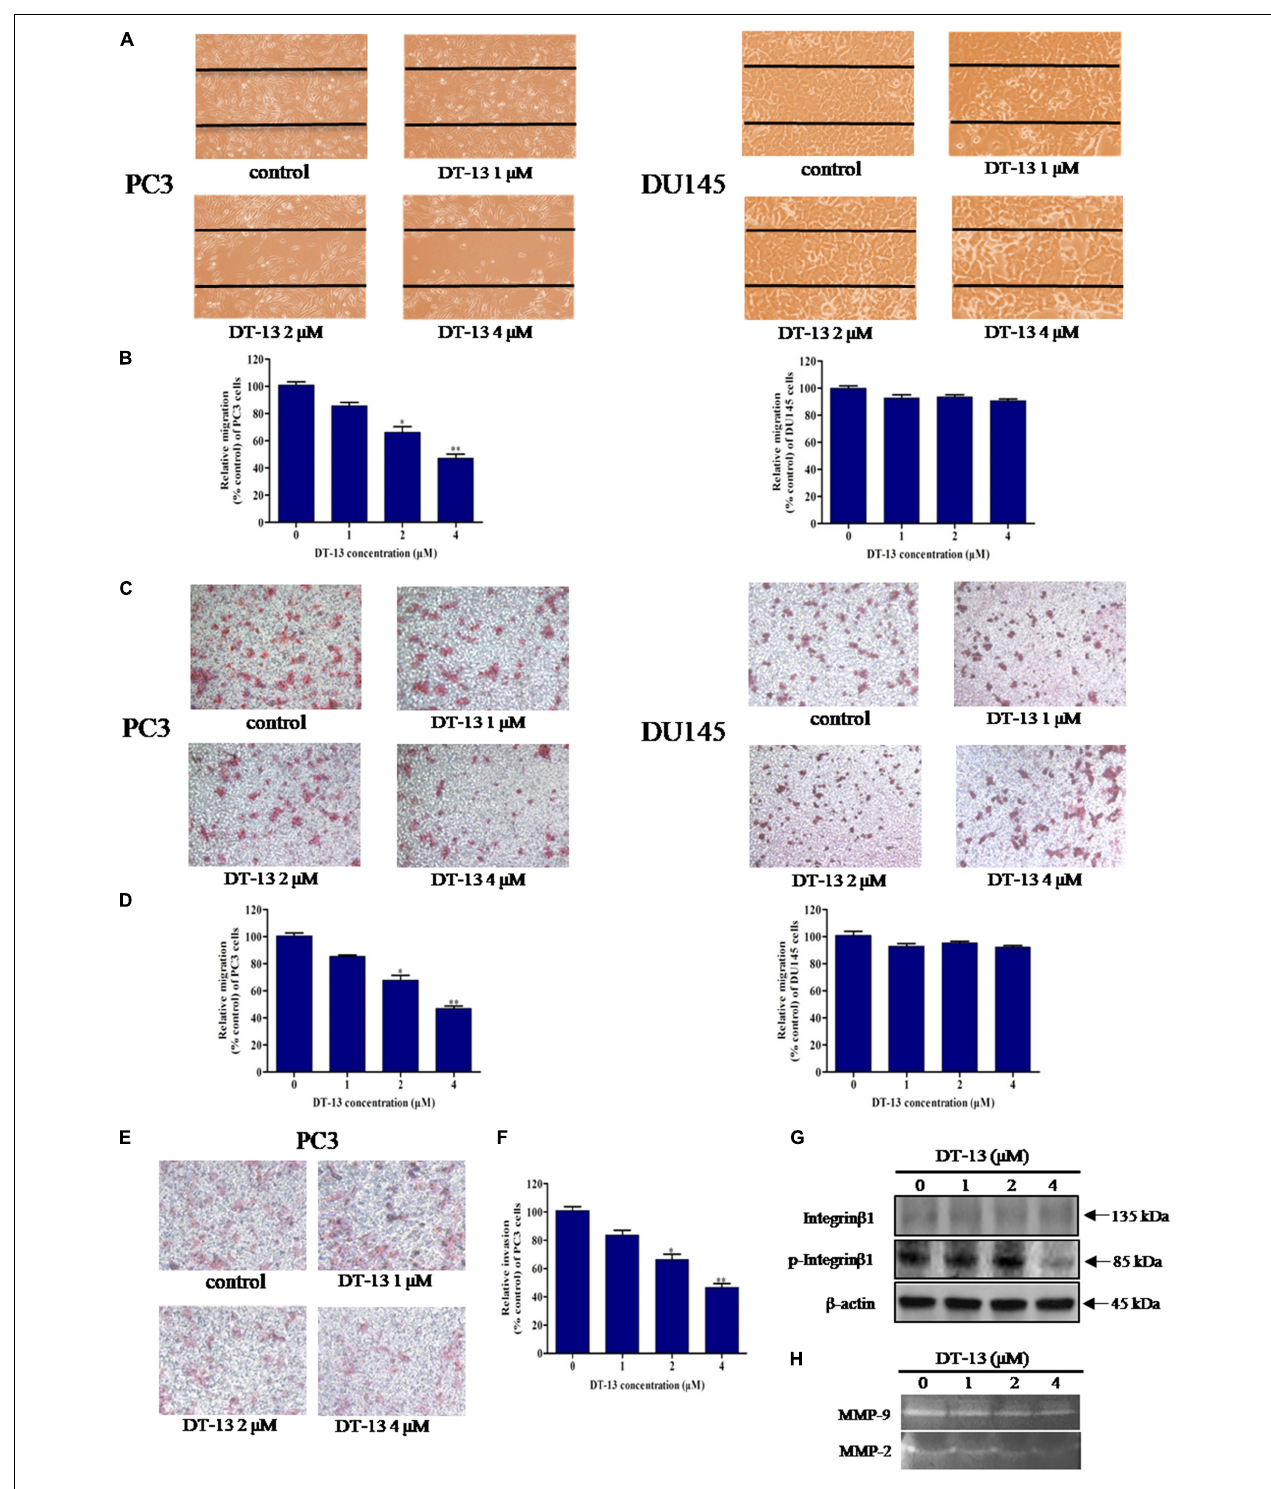
FIGURE 7 | DT-13 inhibited migration and invasion of prostate cancer PC3 cells. (A) Migration of prostate cancer cells with or without DT-13 treatment was determined using wound healing assay. Cells migrated to the wound area were photographed and counted by inverted microcopy. (B) Percentages of PC3 and DU145 cells migrated to the wound area following treatment with DT-13 relative to those of the control cells. Data are mean ± SD, representative of three independent experiments ( n = 3). ∗ p < 0.05, ∗∗ p < 0.01, compared with control. (C) Cells migration potential was assessed by Transwell migration